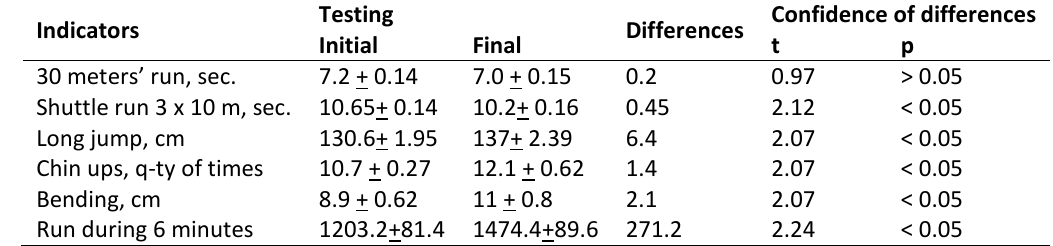
Table 1. Indicators of students’ motor fitness at the beginning and at the end of pedagogic experiment (M+m) Testing Indicators